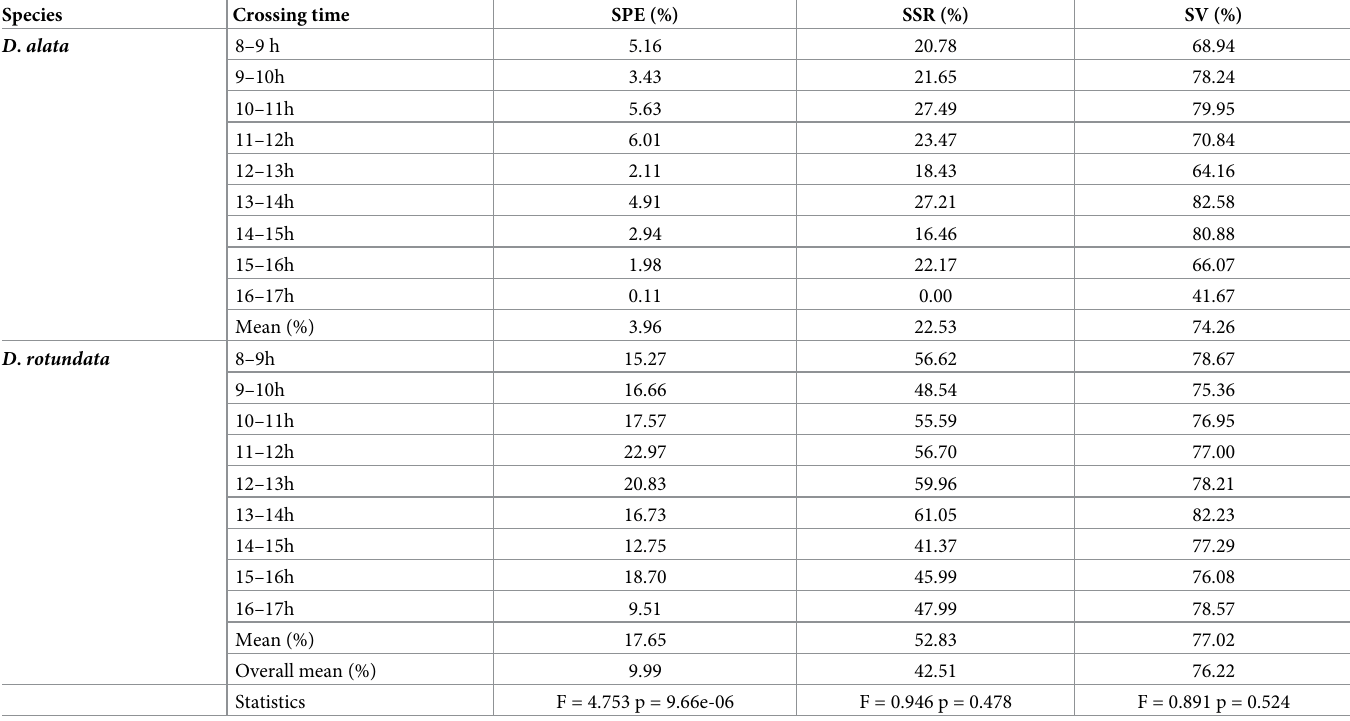
Table 1. Pollination time and seed production efficiency (SPE), seed setting rate (SSR) and seed viability (SV). Species